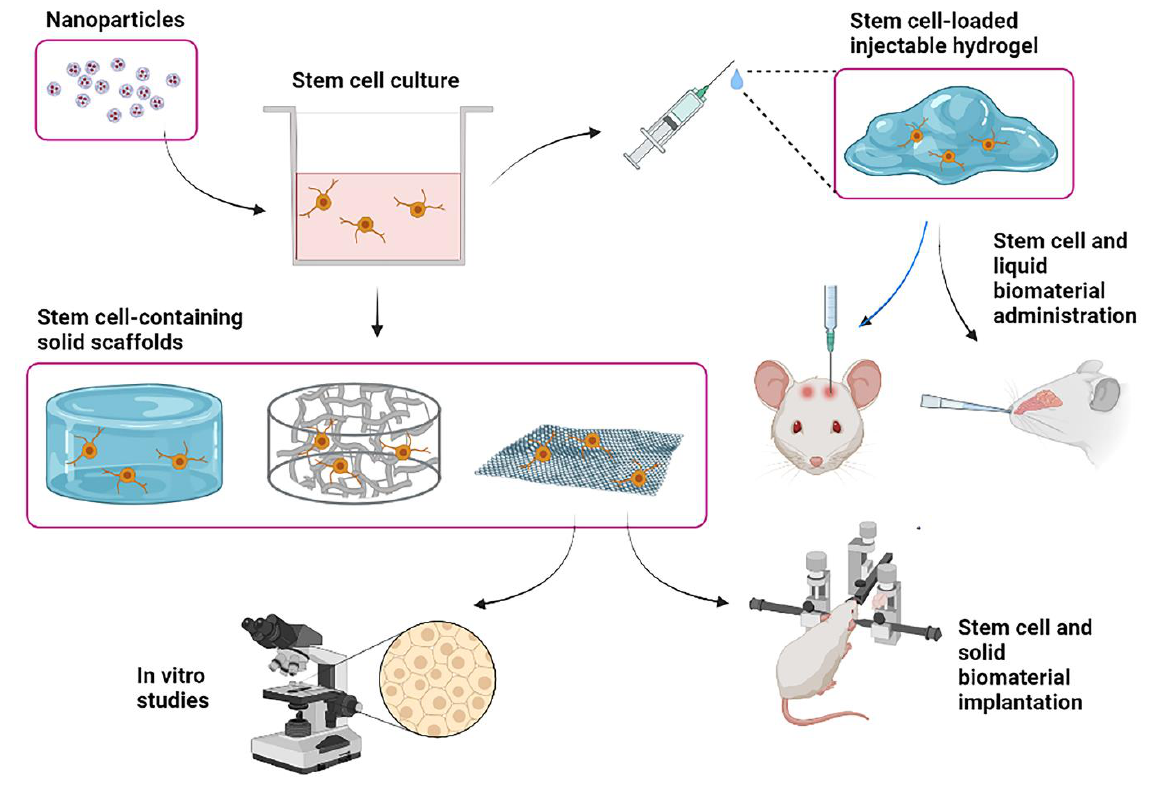
Figure 3. In vitro and in vivo uses of biomaterials in research and for cell therapies to promote regeneration in the context of neurological disorders. Applications include the addition of nanoparticles to the culture medium to guide the behavior of stem cells, the use of solid supports (e.g., hydrogels, nanofibrous scaffolds, and graphene) containing stem cells for in vitro studies and for intracerebral implantation in animal models, and the use of injectable hydrogels for intracerebral or (in the future) intranasal administration.